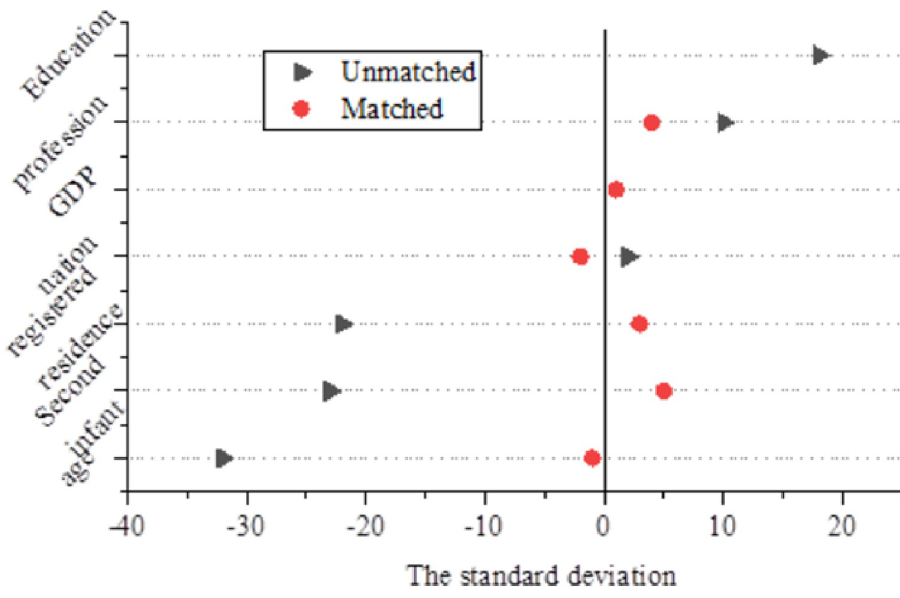
Fig 7. Changes in the standard deviation of the indicators matched.